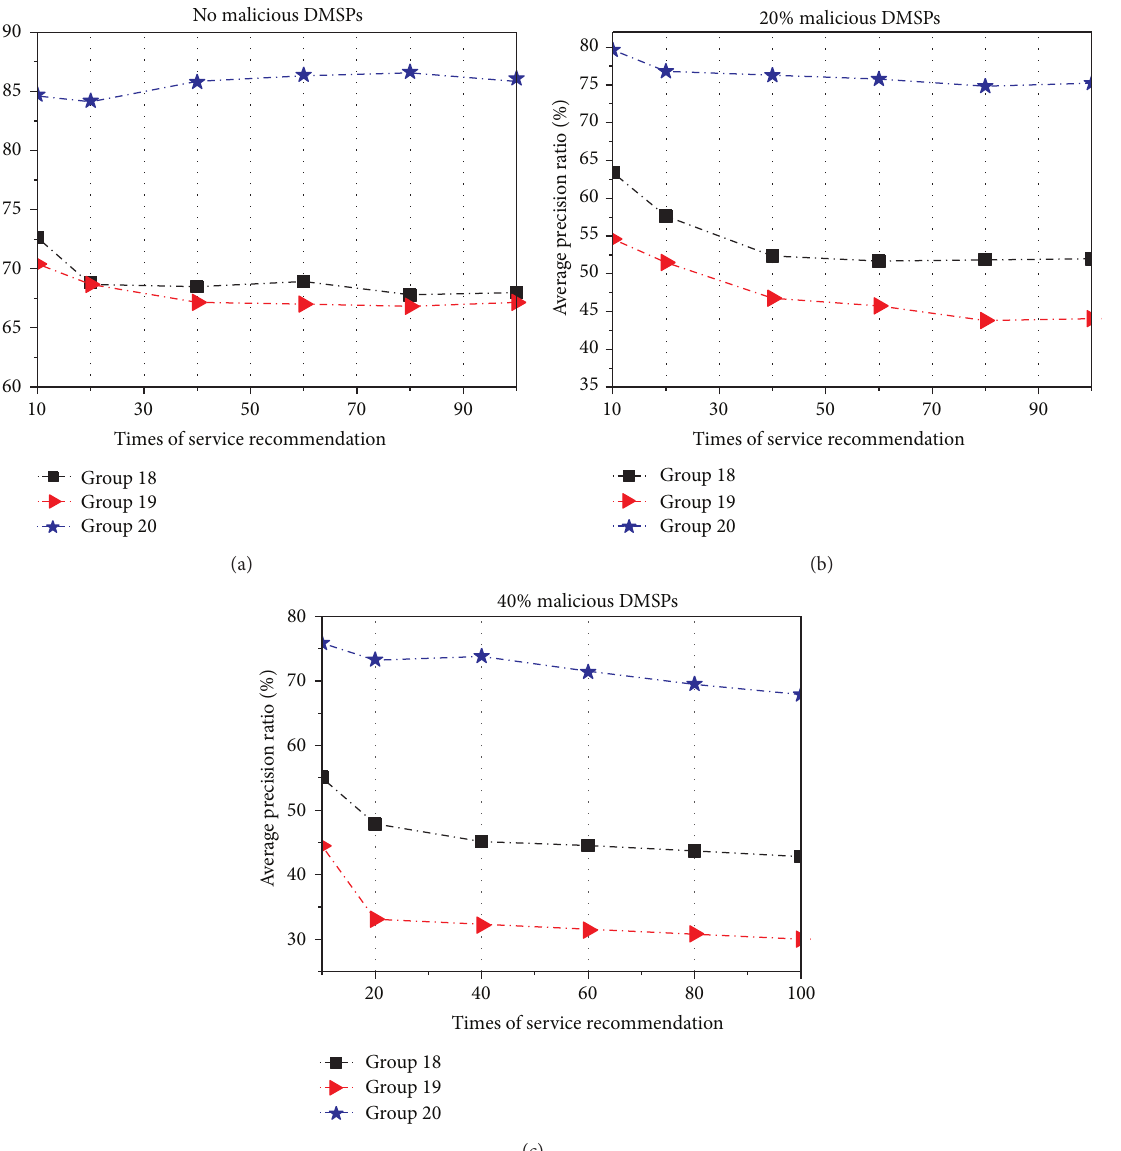
Figure 7: Effects of recommendation-based trust computation for the service